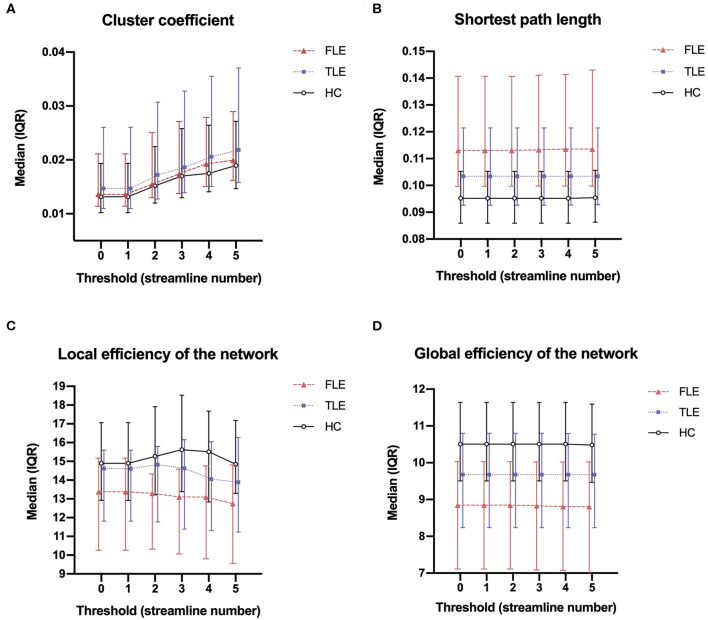
The median (interquartile range) of the cluster coefficient (A), shortest path length (B), local efficiency of the network (C), and global efficiency of the network (D) of the three groups across thresholds of 0, 1, 2, 3, 4, and 5.